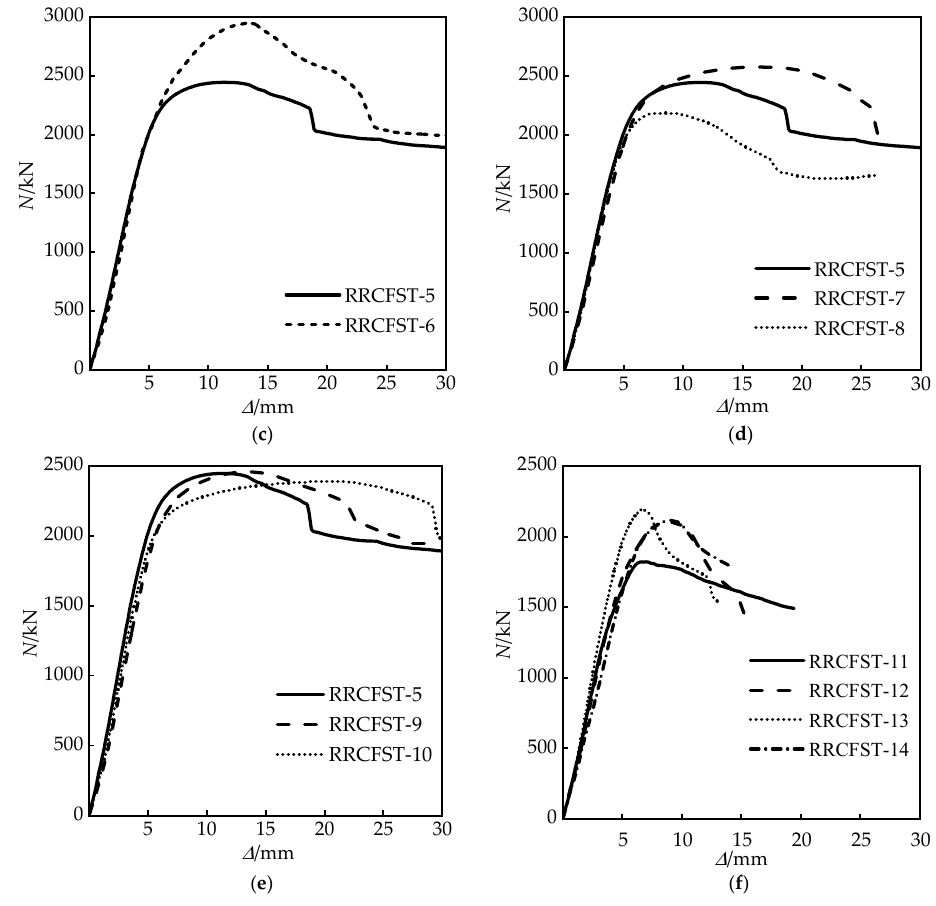
Figure 12. Load–displacement curves of experiments. Figure 12. ( a – f ) Load–displacement curves of